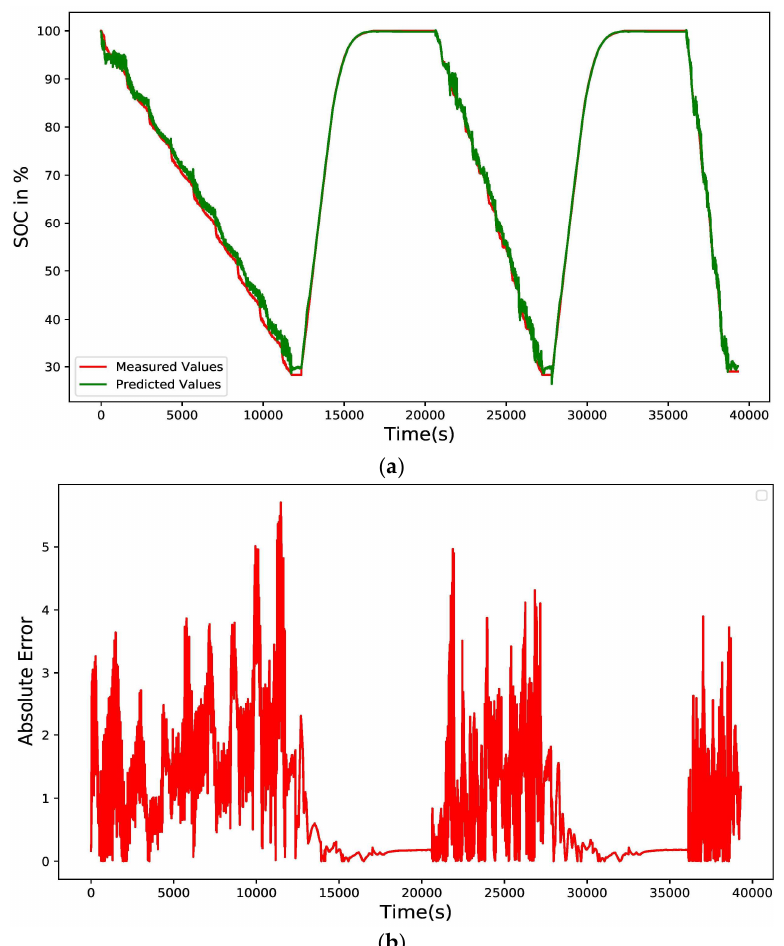
Figure 14. Performance of the hybrid CNN-GRU-LSTM model at −10 °C ( a ) measured and predicted SOC values and ( b ) absolute errors from the test data.